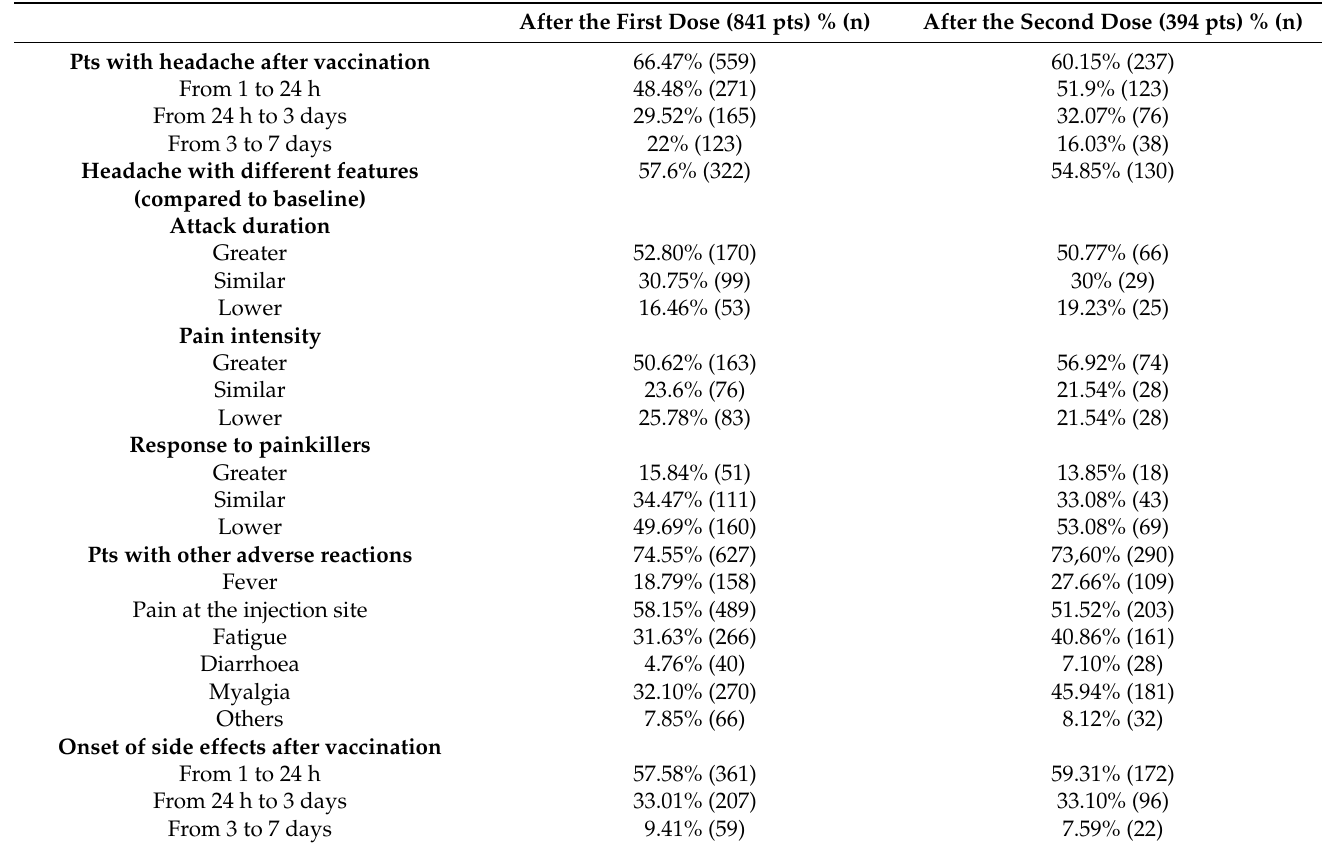
Table 2. Clinical features of headache attacks and local/systemic adverse reactions occurring after COVID-19 vaccine ad-